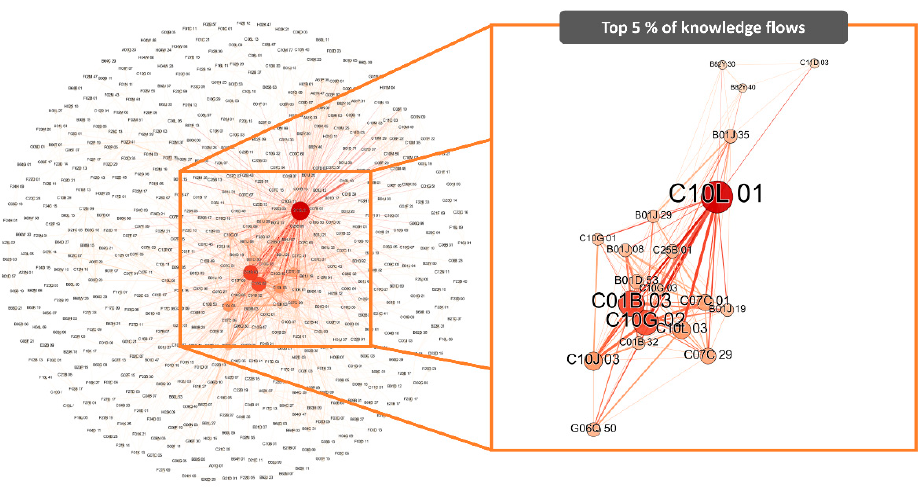
Figure 8. Visualization of knowledge flow network for the e-fuel patent landscape (2010–2021).